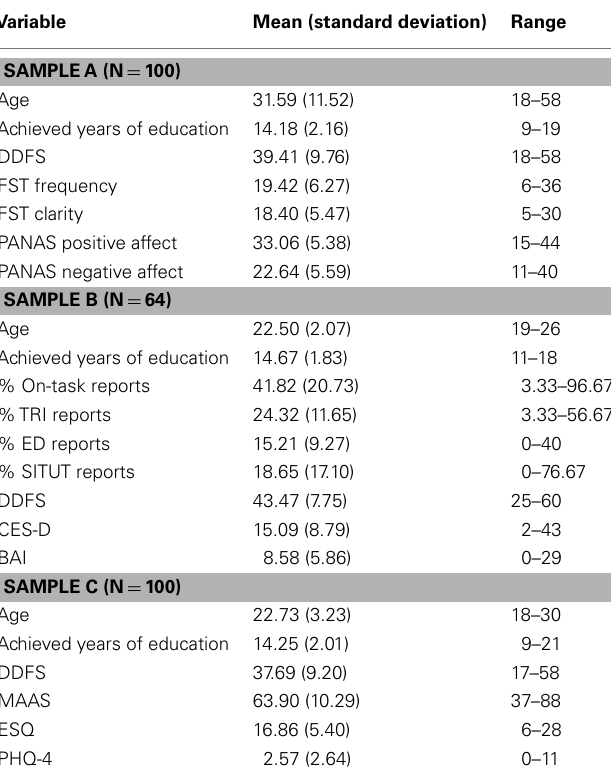
Table 1 | Means, standard deviations, and ranges for the different variables assessed in samplesA, B, and